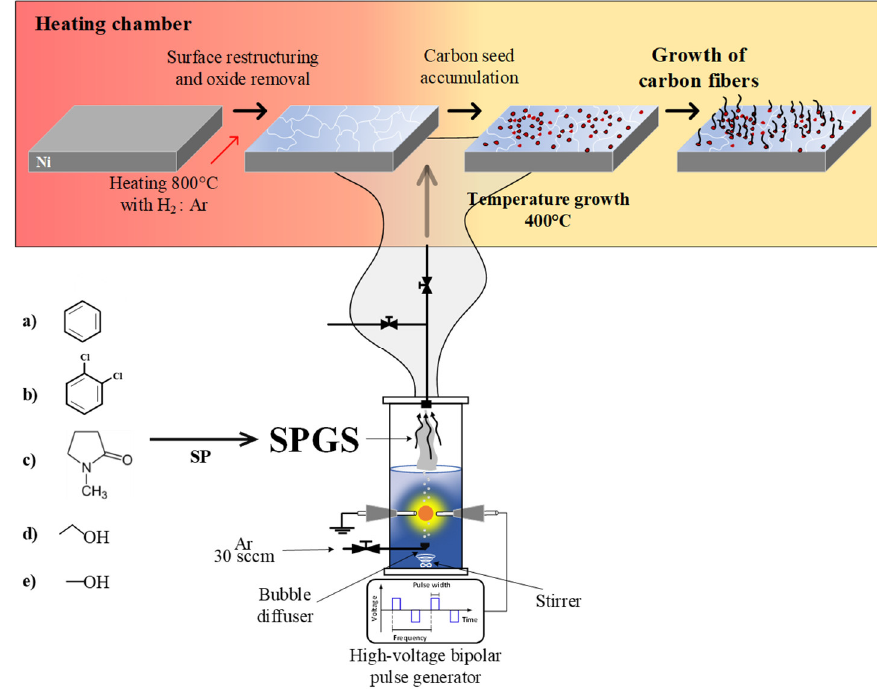
Figure 2. Experimental setup for the growth of carbon fibers using (a) benzene, (b) dichlorobenzene, (c) NMP, (d) ethanol and (e) methanol.